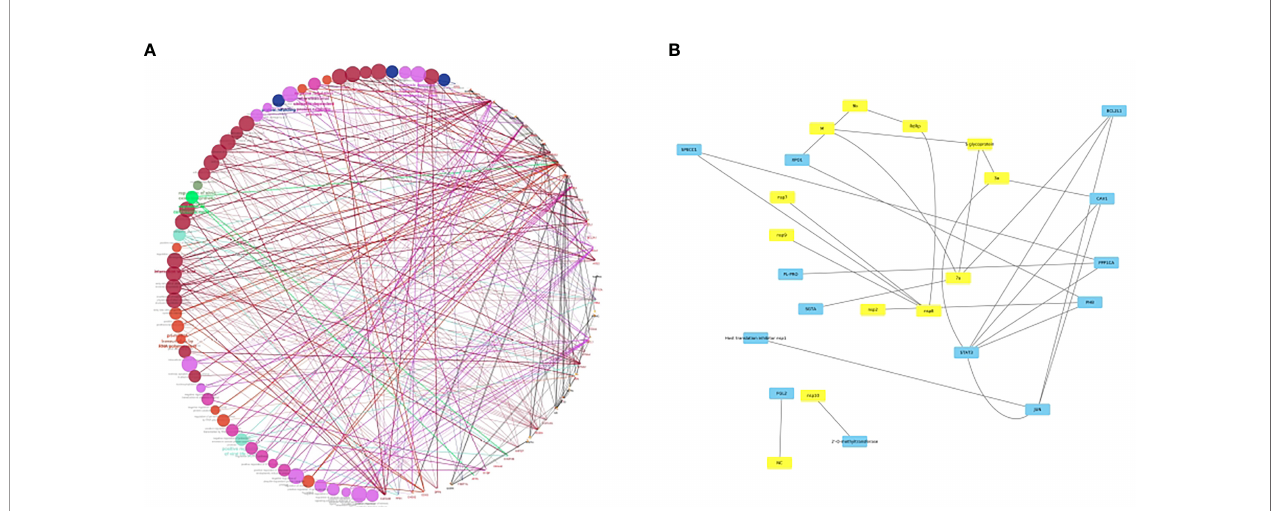
FIGURE 2 | (A) bona fi de network analysis of HCoV-host interactome network. A subnetwork illustrating the HCoV-host interactome where colored nodes represent diverse enriched pathways in host proteins and edge colors represent evidence collected from protein-protein interactions. The Figure was generated using Cytoscape (111) with the host proteins shown to be interacting with the viral conglomerate proteins. The pink edges indicate the experimentally validated interactions, with green, grey, orange, and maroon edges representing fusion, subcellular location, coexpression and associations from text mining. (B) A sub- fi gure with all the viral proteins in yellow colored nodes and the host proteins in blue colored nodes. This fi gure is depicted keeping in view of the interplay of various host-pathogen interactions. A Supplementary Table 1 is added which shows the list of interactants based on the text mining, co-expression network and overall scores. However, as no co- expression network studies have been deciphered yet between virus and the host, the network is distributed largely based on the text mining interactions. In conclusion, the network largely explores how the SARS-CoV-2 proteins have an interplay with a lot of host proteins, viz. SPECC1, a mitochondrial like protein, PHB, a prohibitin associated with cancer and FGL2/ fi broleukin prothrombinase, a protein associated with clotting factors and alveolar macrophage